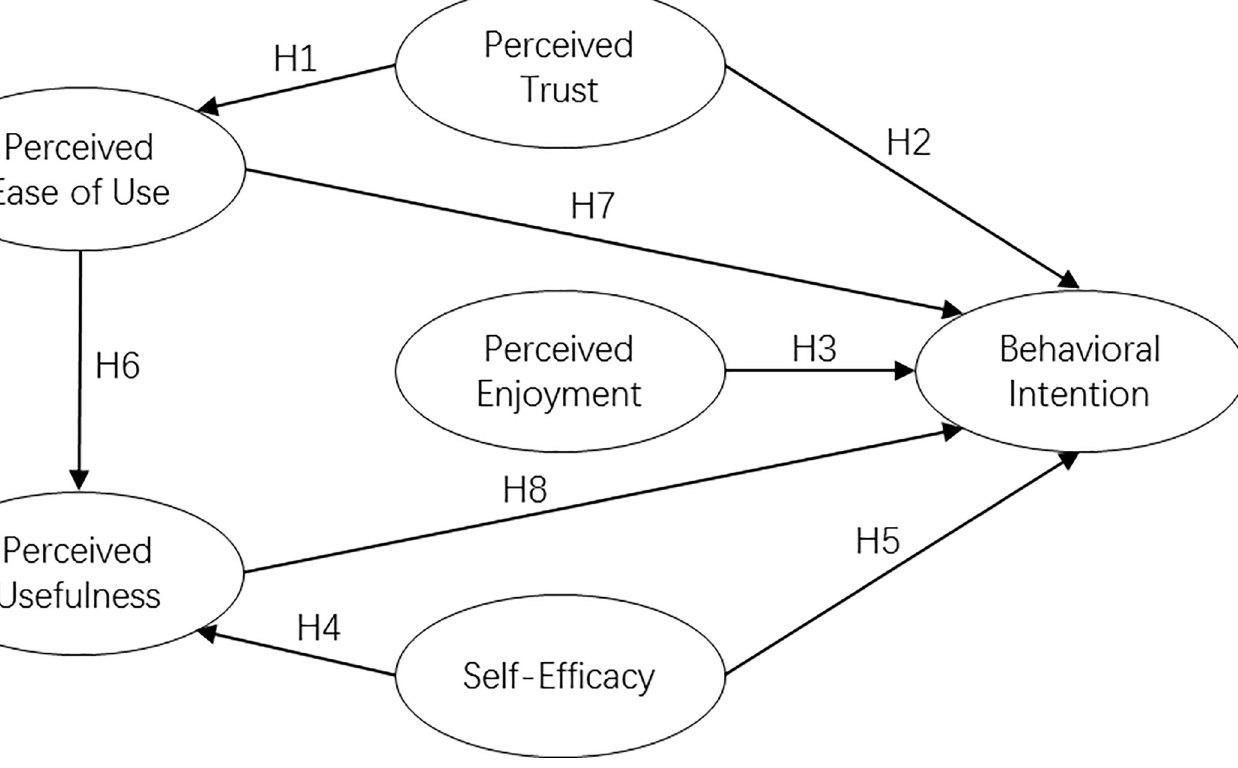
PLOS ONE | https://doi.org/10.1371/journal.pone.0256570 August 20,